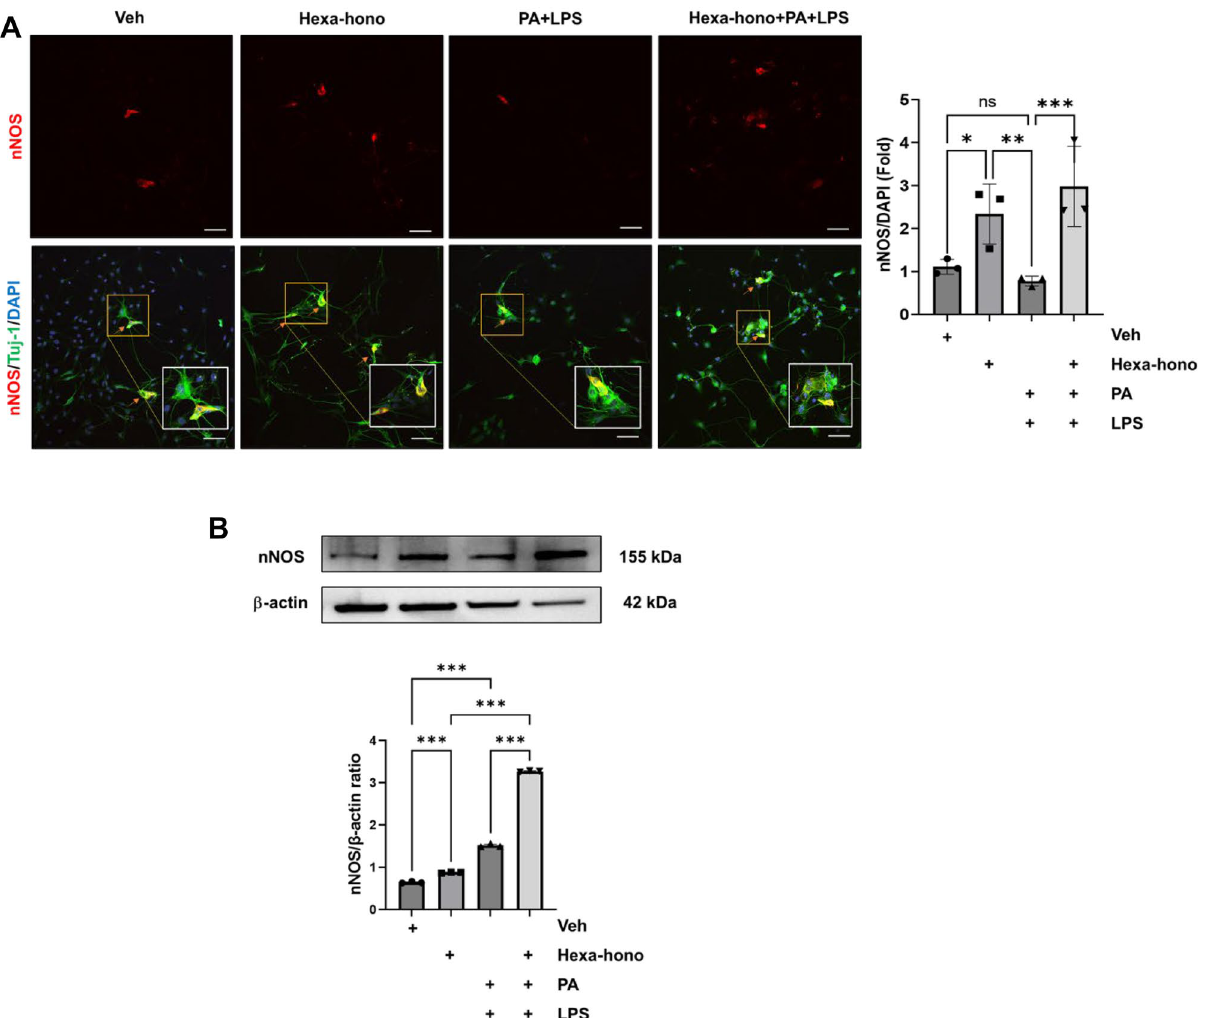
Figure 2. Hexafluoro-honokiol increased nNOS neurons and expression in primary myenteric neuronal and IM-FEN cells treated with Palmitate and LPS. ( A ) Representative confocal microscopy images of primary myenteric neurons treated with Vehicle, Hexafluoro-honokiol (10 μM), PA (0.5 mM) with LPS (0.5 ng/ml), and Hexafluoro-honokiol with PA and LPS, cultured for 24 h, and probed for nNOS, Tuj-1, and DAPI as a nuclear stain. The histogram represents the percentage of the number of nNOS neurons with respect to the total number of DAPI-stained cells. ( B ) Western blot was run with protein lysates from IM-FEN cell lysate probed for nNOS and β-actin as a loading control. The histogram shows nNOS band density normalized to β-actin. The uncropped Western blot images of Fig. 2B has been provided in the supplementary file. Both protein of interest and loading control were run on a single membrane. Data are the mean ± SEM from three independent experiments. ns = non-significant; * P < 0.05; ** P < 0.01; *** P < 0.001; (2-way